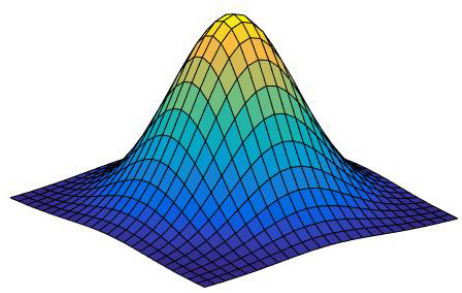
Figure 2. Gaussian window v ( x , y )